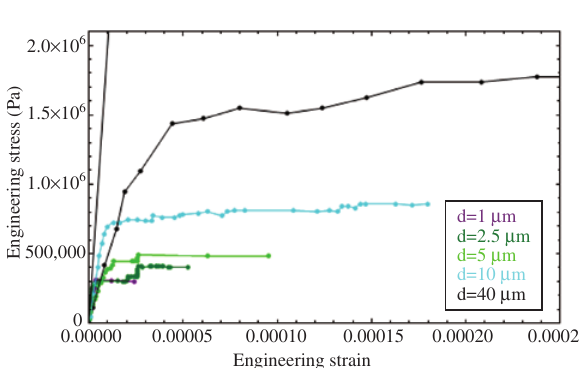
Figure 3: Recalculated engineering stress-strain graphs of pure Ni micropillar compression using Eq. 3. The slope of the straight line provides a modulus value of 200